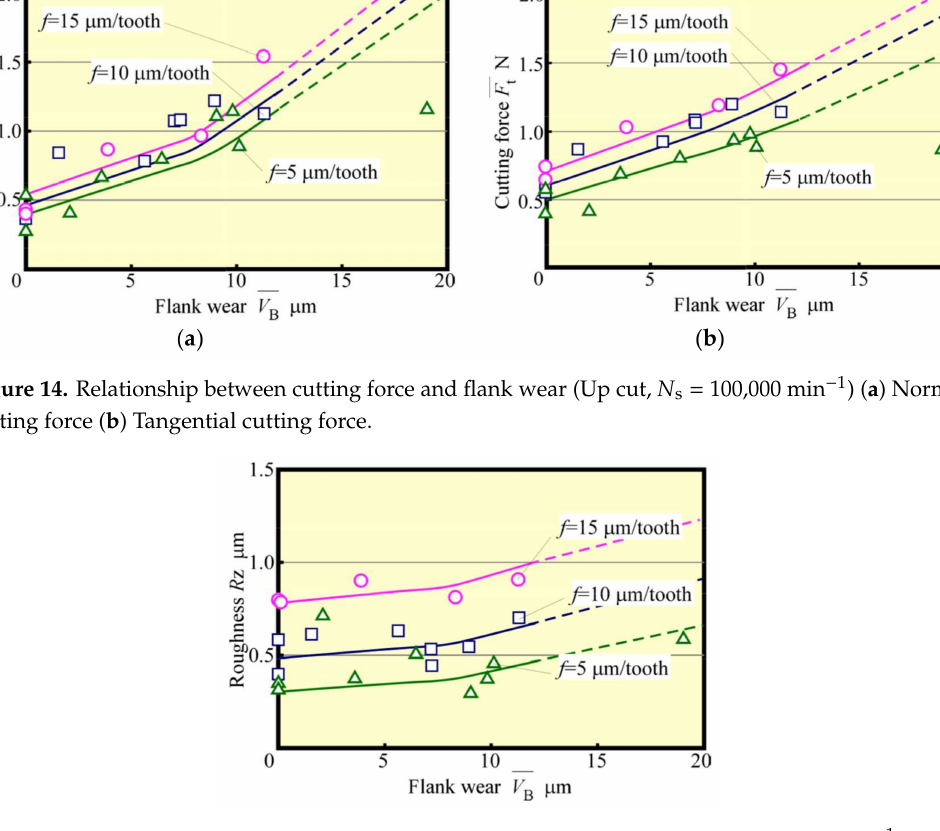
Figure 15. Relationship between roughness and flank wear (Up cut, N s = 100,000 min − 1